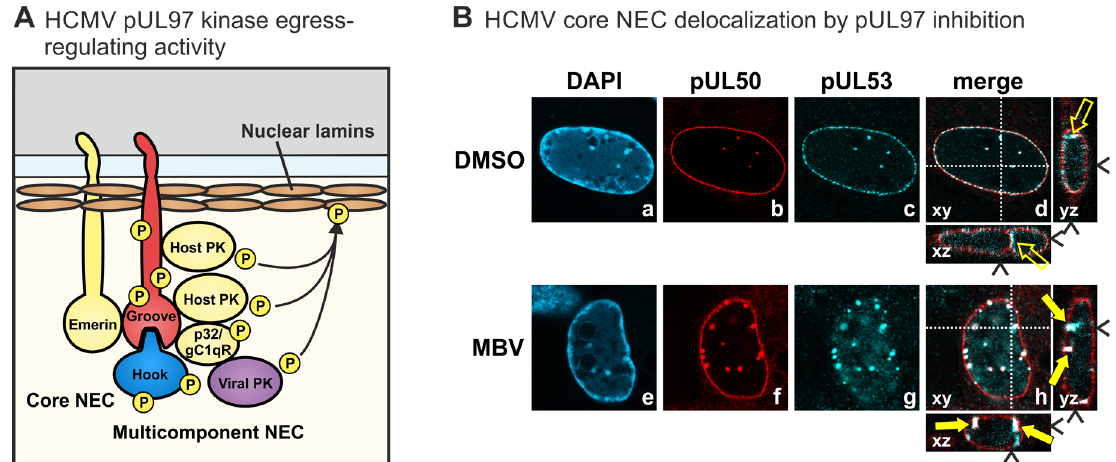
Figure 8. ( A ) The HCMV-encoded protein kinase pUL97 exerts a nuclear egress-regulating activity through the phosphorylation of nuclear lamins and additional proteins of the core and multicomponent NEC, including the hook and groove proteins themselves. ( B ) The HCMV core NEC undergoes a microscopically visible delocalization upon treatment with pUL97 inhibitors such as MBV or others. Specifically, treatment of HCMV-infected cells with the pUL97 inhibitor MBV results in intranuclear aggregates of pUL50 and pUL53. HFFs infected with recombinant HCMV AD169-GFP UL50-HA and treated with MBV (5 µM) or DMSO at 74 and 94 h post-infection (h p.i.). Cells were fixed at 96 h p.i. and subjected to indirect immunofluorescence analysis, and the subcellular localization of viral pUL50 and pUL53 was detected by recording confocal z-series. Representative images of a single focal plane (xy) were depicted for individual stainings, and xz and yz axes were depicted for merged images. White dotted lines and black arrowheads, optical section through the z stack (xy) or the focal plane (xz and yz); yellow-filled arrows, intranuclear aggregates of pUL50/pUL53 colocalization; yellow open arrows, transnuclear transport channels common in human fibroblasts (modified from